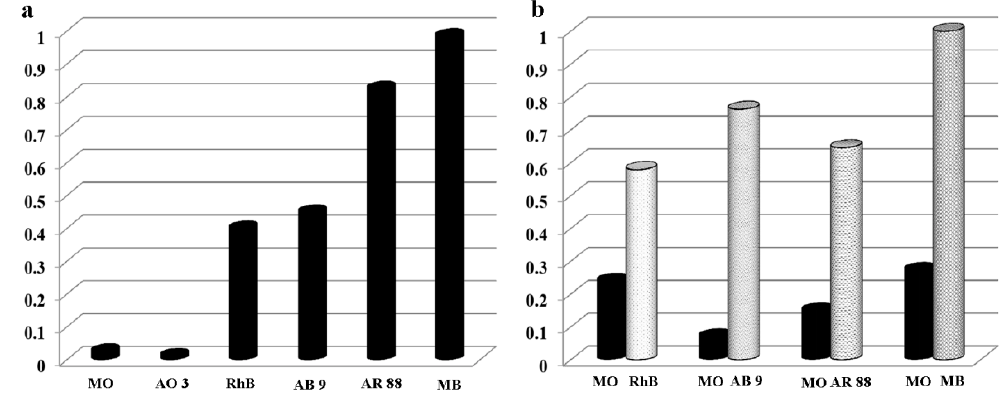
Figure 10. The adsorption histogram of HNTs toward various separate organic dyes ( a ) and mixed dyes ( b ).